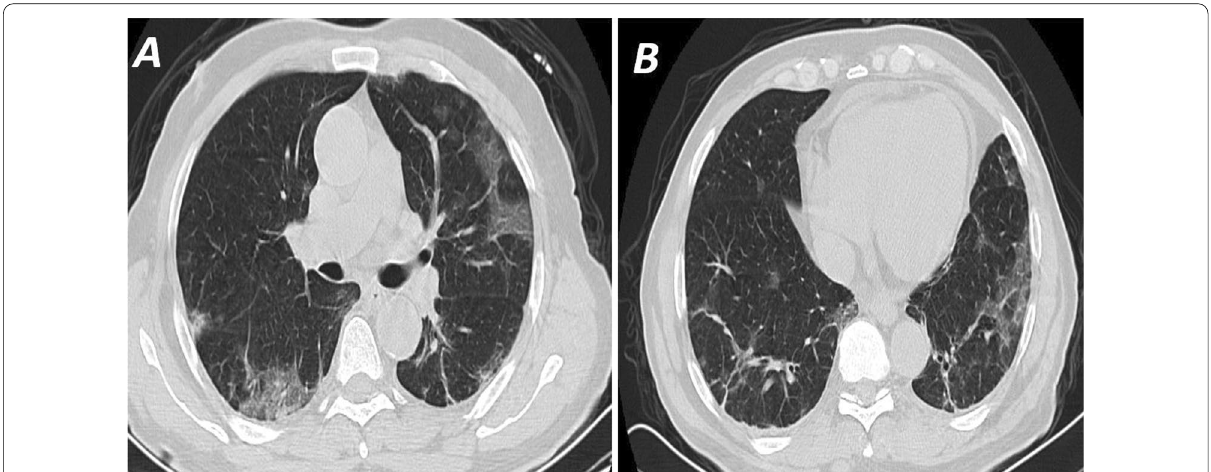
Fig. 2 A and B High‑resolution CT scan (axial cuts) for a 60 year‑old diabetic male patient presented with fever and cough. CT shows multiple bilateral peripheral patches of ground‑glass opacities in both lung lobes with linear consolidations seen in both lower lung lobes interpreted by all readers as a high probability (CO‑RADS 5). RT‑PCR was positive for COVID‑19 and the patient responded to treatment and was discharged 14